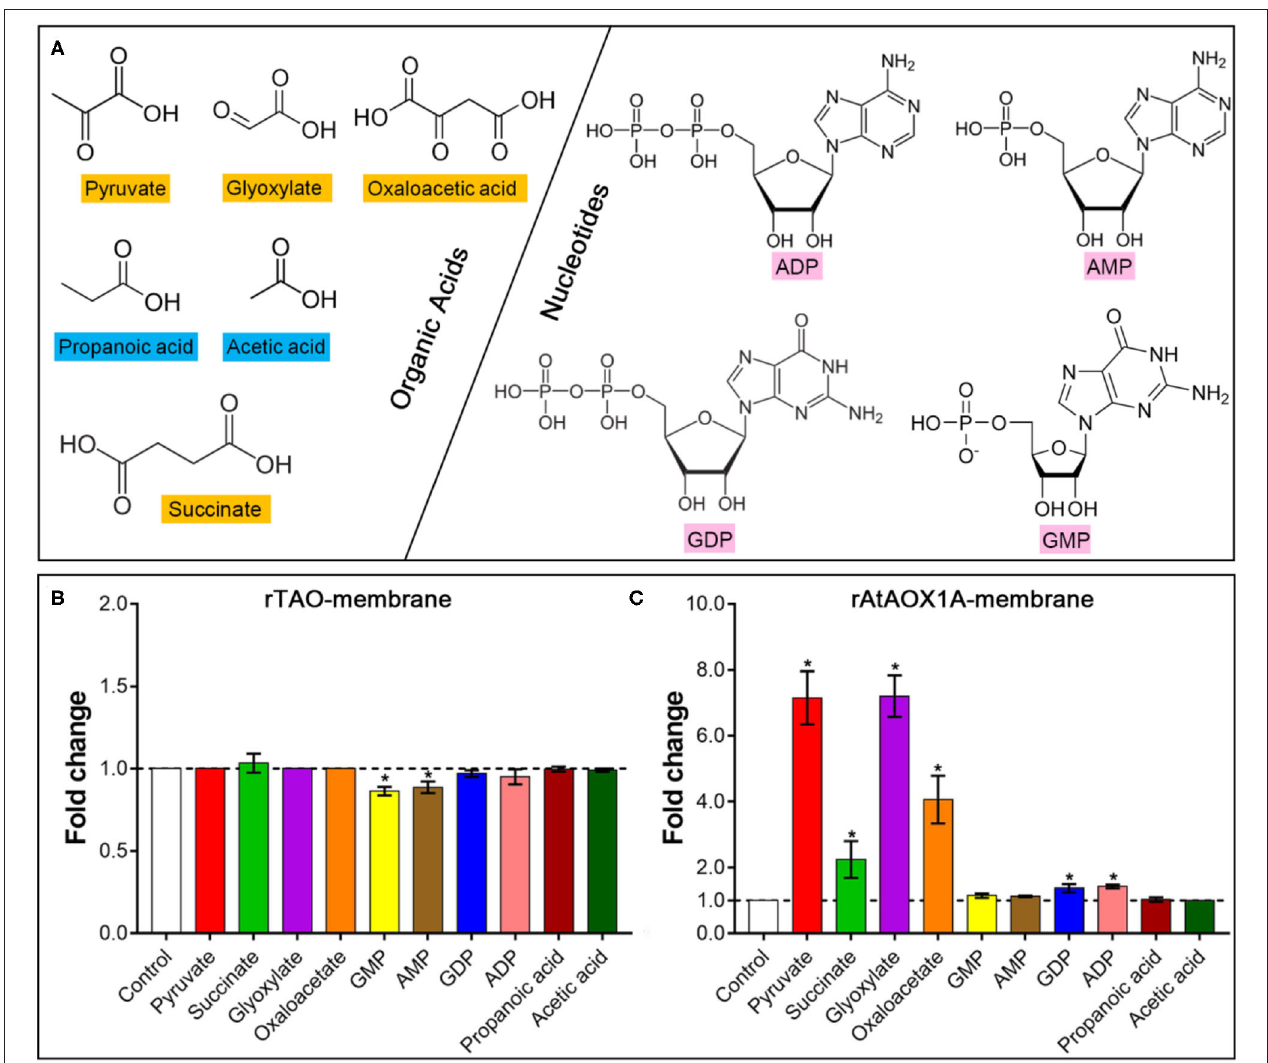
FIGURE 5 | Effects of different effectors on the oxygen consumption rate of AOX proteins. (A) Chemical structures of organic acids and nucleotides are shown. Fold changes of rTAO (B) and rAtAOX1A (C) after treatment with different effectors. Within this experiment, membrane-bound proteins were used for the activation test. For the substrate, 1mM NADH was used, and 1mM KCN was added to avoid the leaking respiration pass through complex IV. Basal activities (no effector, control) were ∼ 8 µ mol O 2 min − 1 mg − 1 protein for rTAO and rAtAOX1A. According to the results of titration, 10mM of effectors were used in this experiment. Asterisks (*) represent the significant difference ( p < 0.05) between the treated samples and the